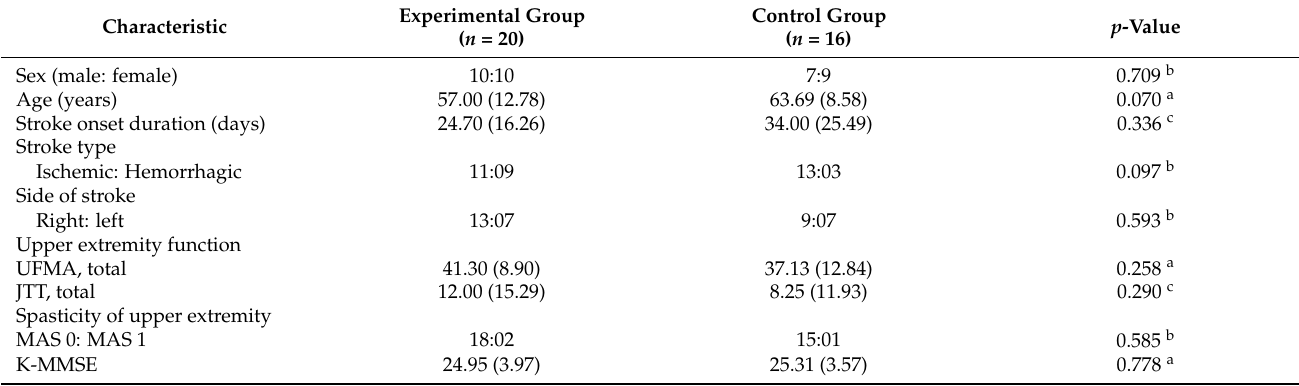
Table 1. Baseline characteristics of the study